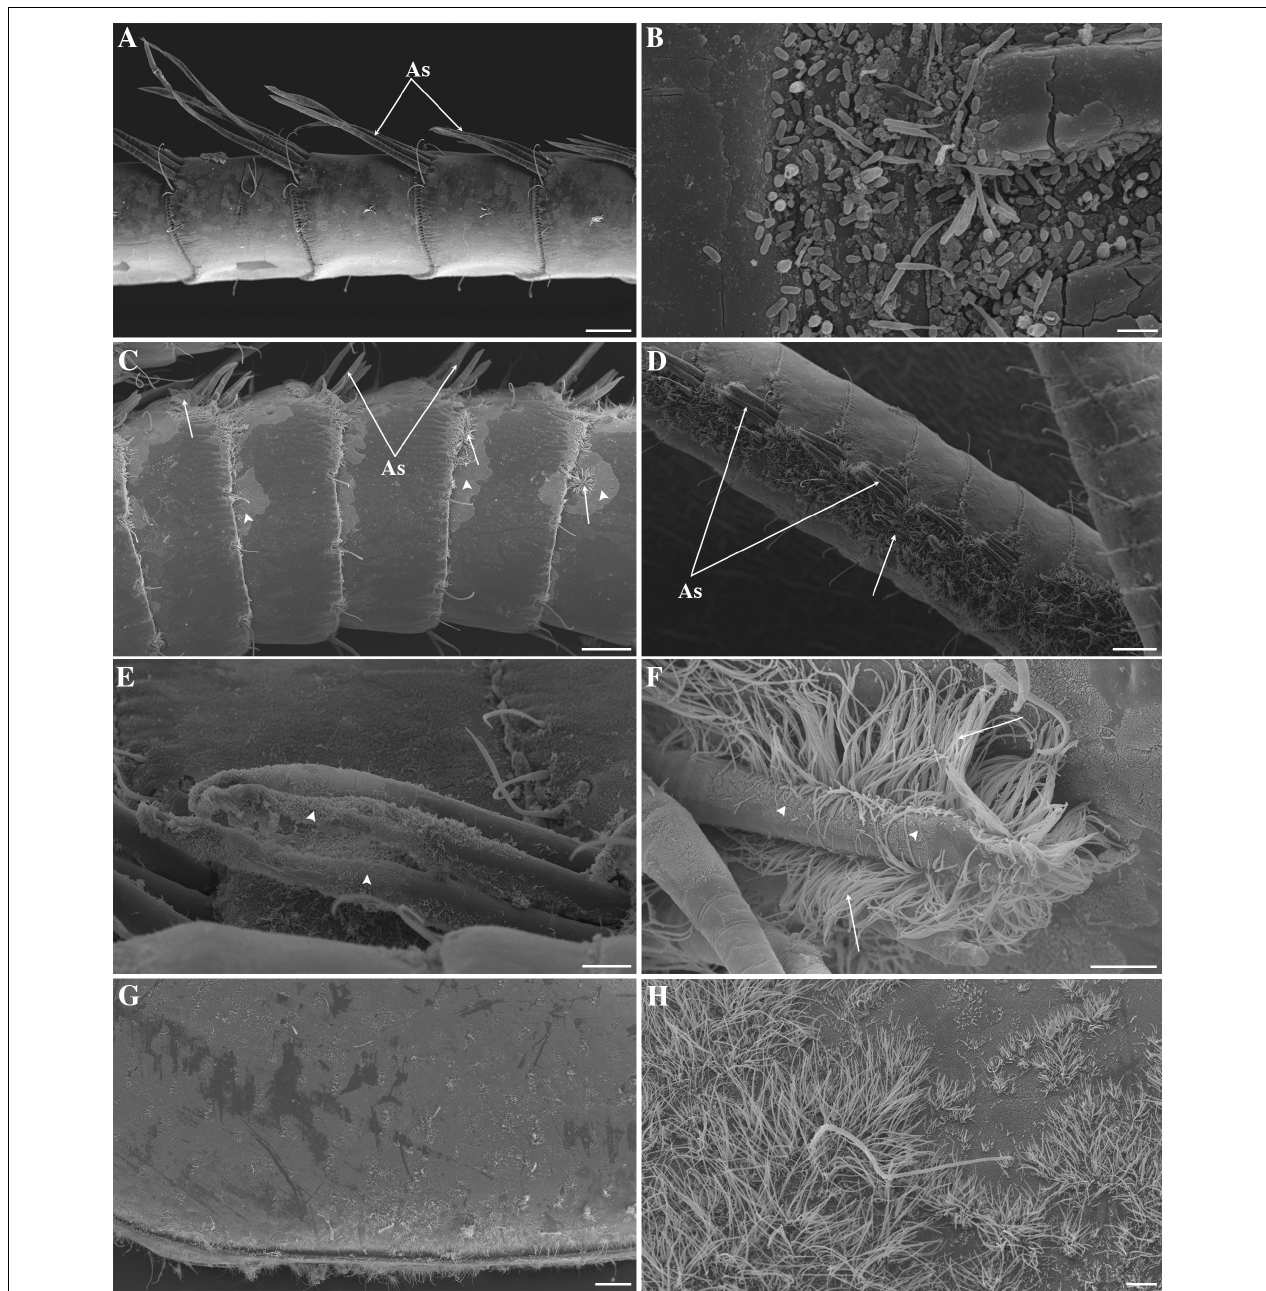
FIGURE 3 | Scanning electron micrographs of Alvinocaris markensis , Rimicaris chacei and Rimicaris exoculata antennae and branchiostegite. (A) Alvinocaris markensis lateral antennular flagellum bearing the aesthetascs (As) and almost devoid of bacteria. (B) Close-up on an intersegment of the antennae of A. markensis colonized by rods and rods tapered at their extremity. (C) Rimicaris exoculata lateral antennular flagellum bearing the aesthetascs (As). Patches of rods are visible (arrow heads) along with some short filamentous bacteria (arrows). (D) Rimicaris chacei lateral antennular flagellum bearing the aesthetascs (As), surrounded by patches of filamentous bacteria (arrows). (E,F) Closes-up on the aesthetascs (As) of M. fortunata (E) and R. exoculata (F) , covered by rods (arrows heads) and filamentous bacteria (arrows). Scale bars: (A,C,D) = 100 µ m; (B) = 2 µ m; (E,F,H) = 20 µ m; (G) = 200 µ m.